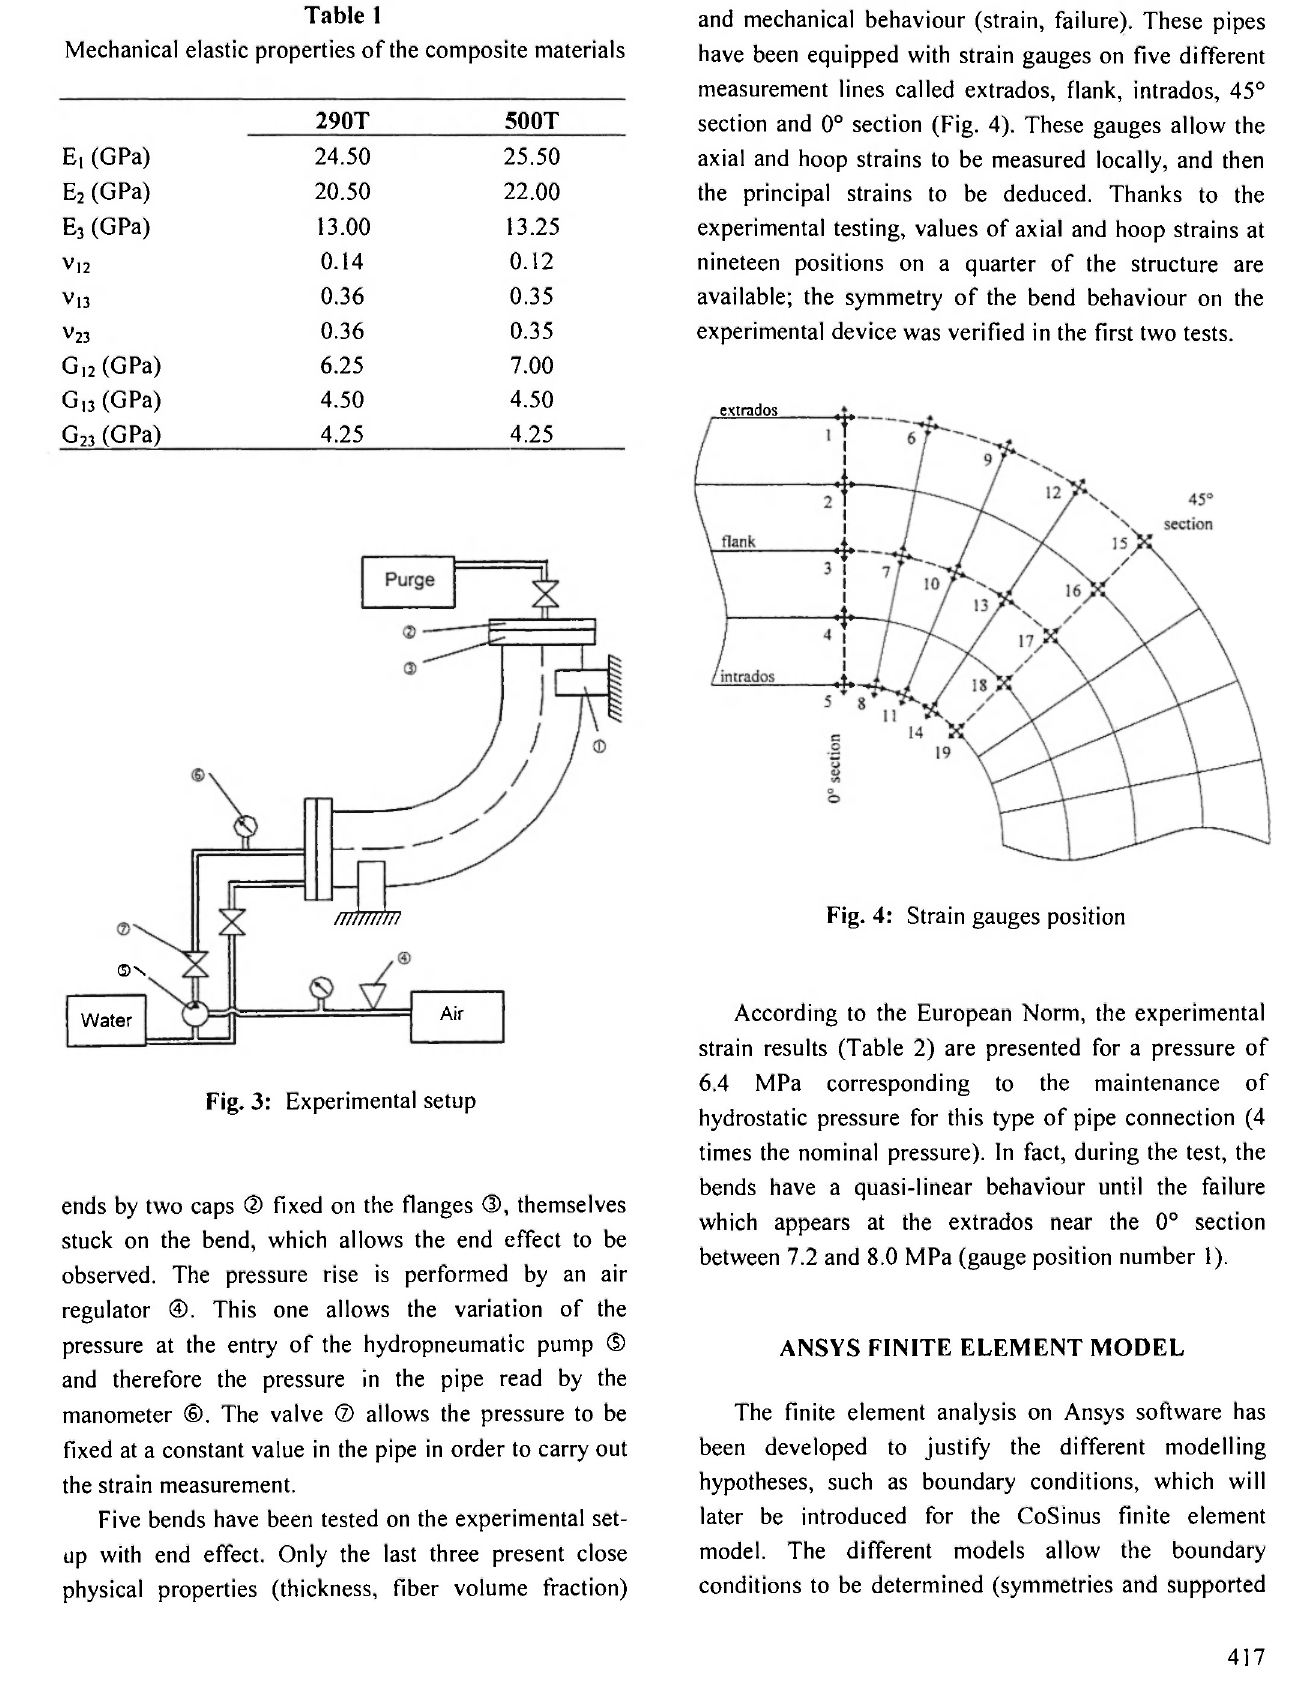
Fig. 3: Experimental setup